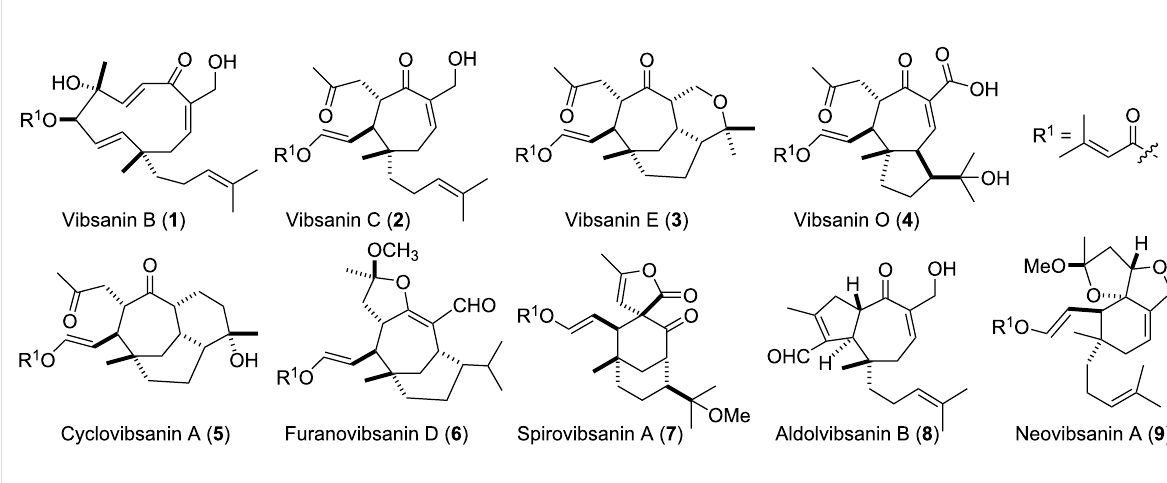
Figure 1: A collection of the structural diversity seen in the vibsanin type diterpene family.